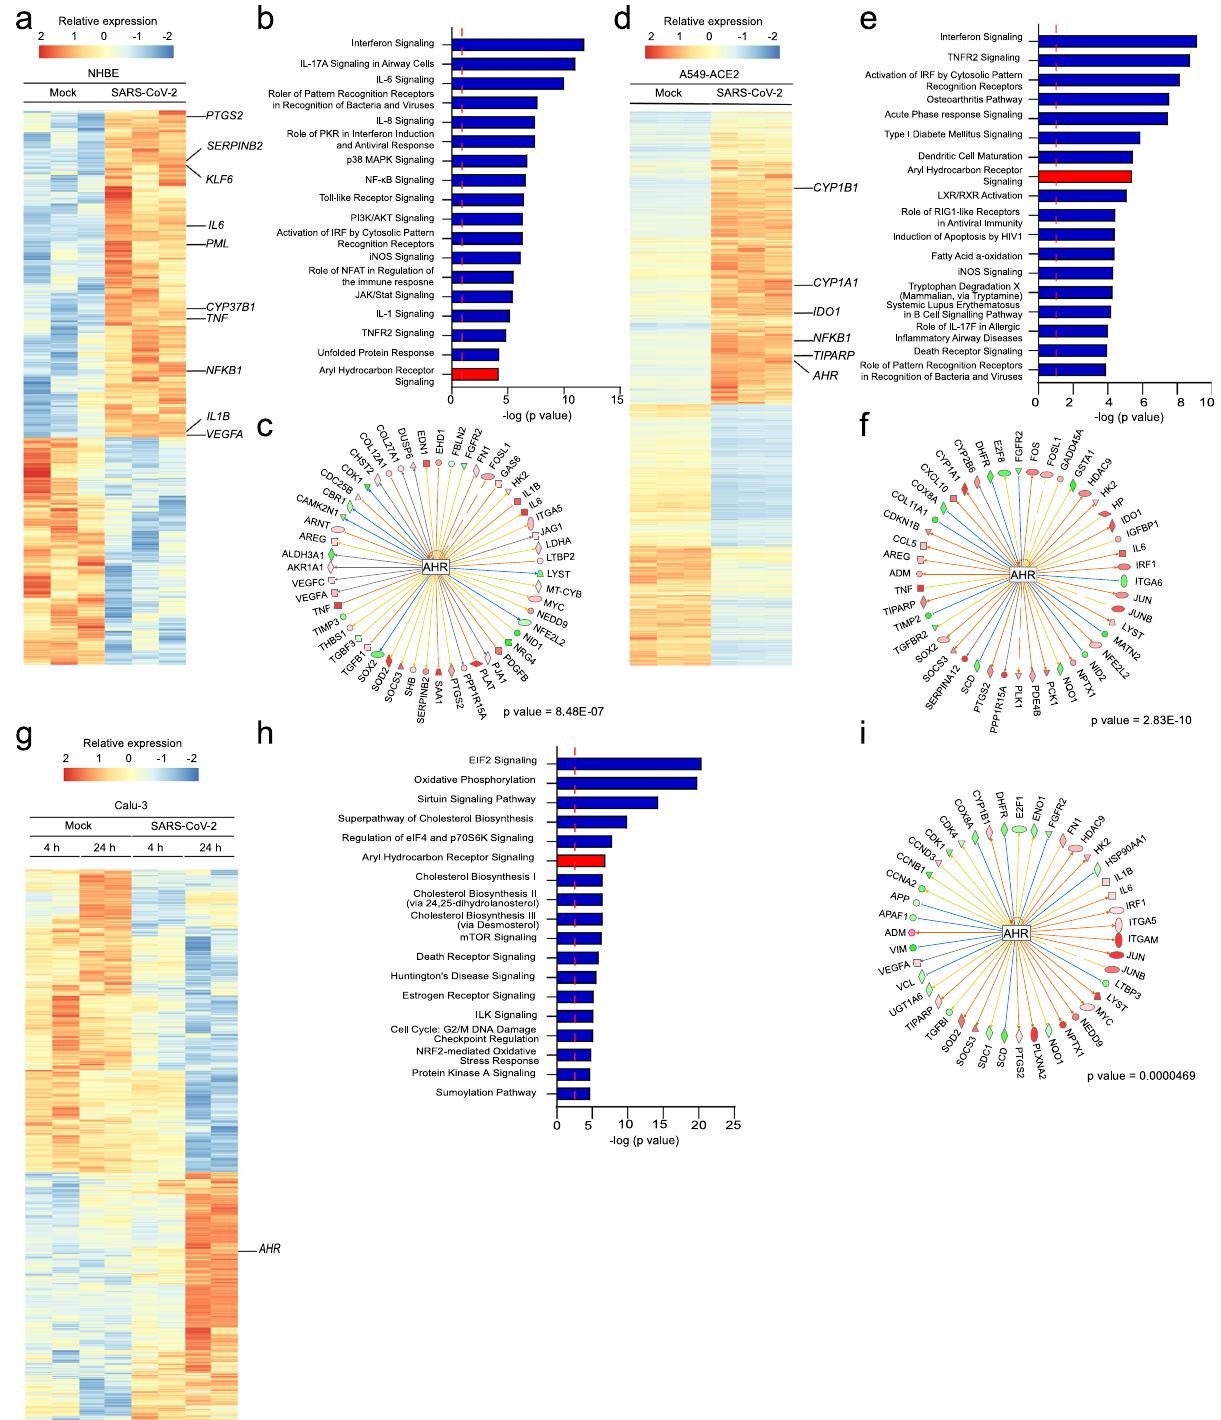
AHR signaling (Fig. 4b, Supplementary Data 1). Finally, upstream (Fig. 4c). In addition, a cell fate trajectory analysis (which uses gene expression to model the cell fate), showed that the uninfected cells and the infected cells spread at the end of the trajectory line (Fig.4d). AHR and PML expression are most highly expressed on the infected end of the trajectory, as shown by a pseudo-time analysis (Fig.4e). Taken together, these fi ndings suggest that AHR signaling is upregulated in COVID-19